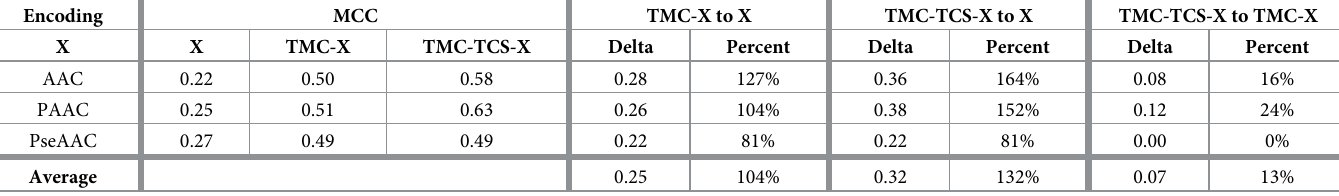
Table 6. Impact of factors on